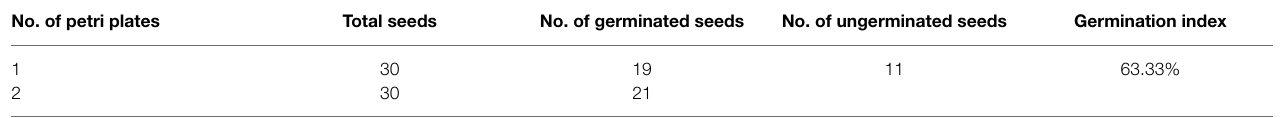
TABLE 2 | Germination index.